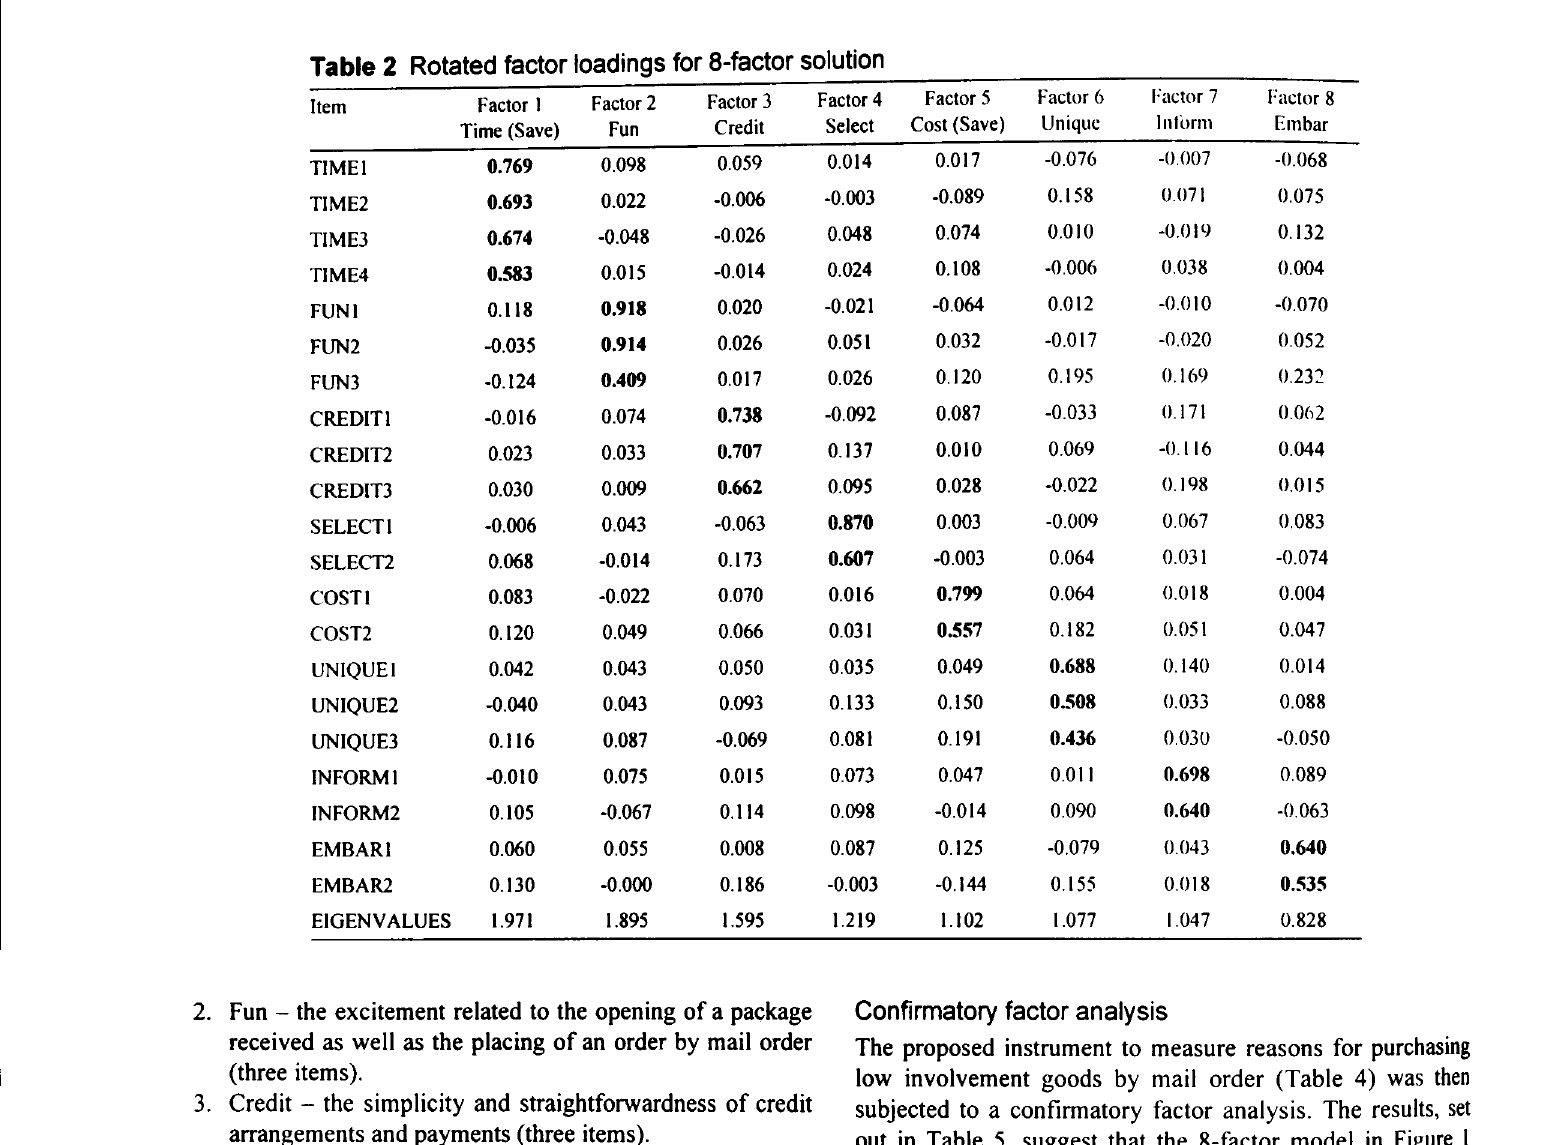
Table 2 Rotated factor loadings for 8-factor